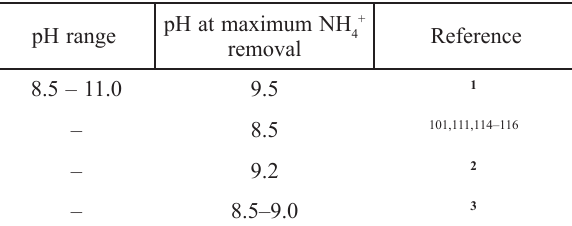
Table 5 – Optimal pH for maximum ammonium ion removal at molar ratio of Mg:NH